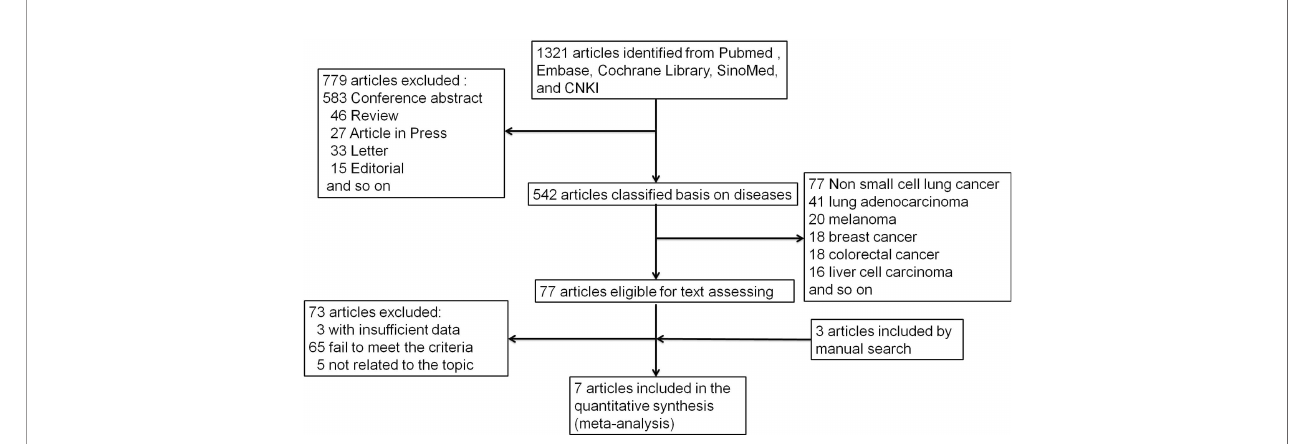
FIGURE 1 | Flow chart of literature